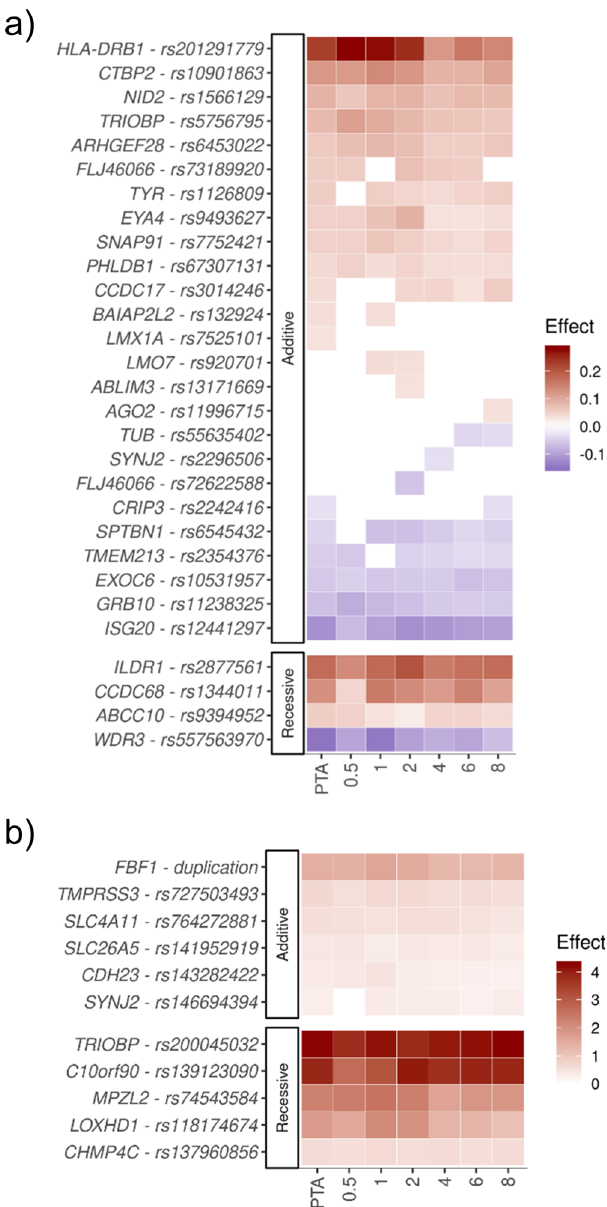
Fig. 5 Effects of the ARHI variants on ARHI per frequency. Each row shows the effect, the logarithm of the estimated odds ratios, of the minor allele on ARHI for PTA, the average of 0.5, 1, 2, and 4 kHz, and separately for each frequency, 0.5, 1, 2, 4, 6, and 8 kHz, for a common variants with EGF > 1% and b rare variants with EGF < 1%. The effect is shown only for associations with P -value <0.05. Red color represents an increased risk of ARHI and blue color represents decreased